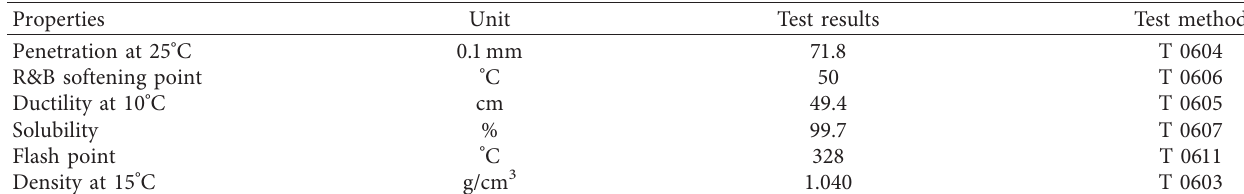
Table 1: Properties of asphalt